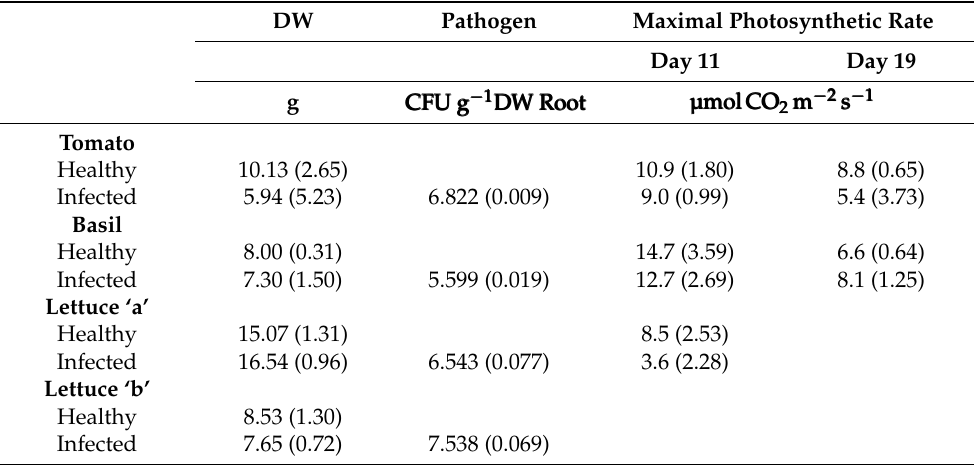
Table 3. Reference measurements in the Pythium ultimum experiment. Mean values with standard deviations within parenthesis of three measurements in each